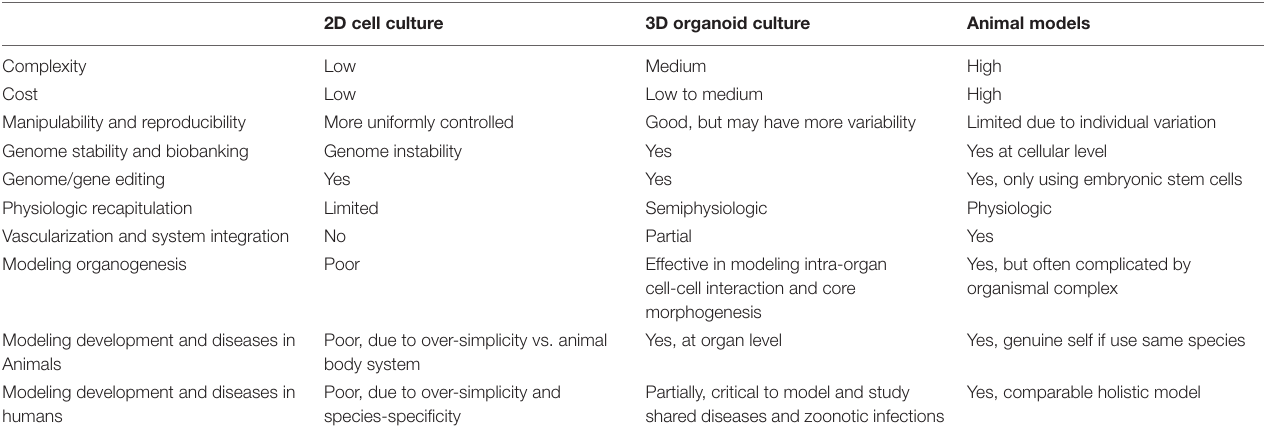
TABLE 1 | Comparison of 3D organoid culture with conventional cell cultures and animal models (Shanks et al., 2009; Yin et al., 2016; Kaushik et al., 2018; Lehmann et al., 2019; Mead and Karp, 2019; Moghaddam et al., 2019; Corrò et al., 2020; Duque-Correa et al., 2020; Fuchs and Blau, 2020; Kim et al., 2020; Hofer and Lutolf, 2021; Kar et al., 2021; Pain,